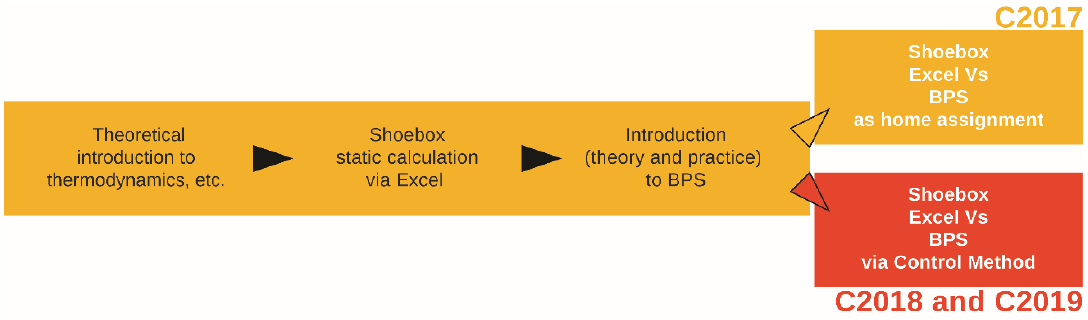
Figure 4. Detailed schedule for the introduction of Building Performance Simulations (BPS) in the “ Energy use and thermal comfort ” course. The comparison between Excel and BPS was guided via the control method for the 2018 and 2019 classes (indicated by C2018 and C2019 in figure).